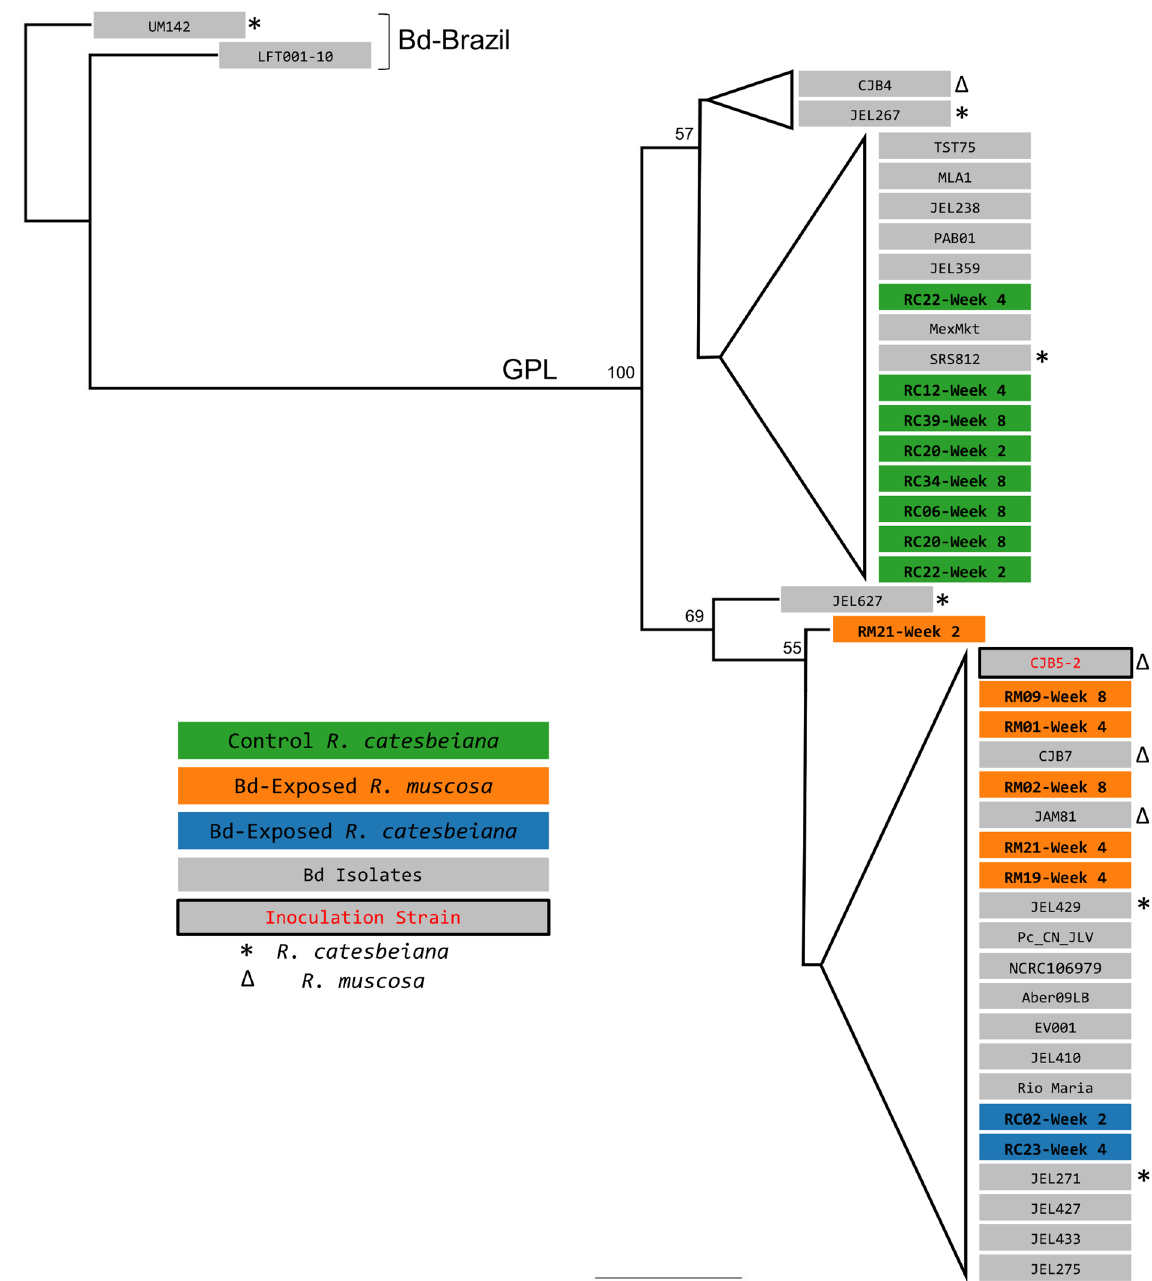
Fig 3. Phylogenetic comparison of Bd DNA collected via swabs during the experiment. Best-scoring maximum likelihood tree for 26 Bd isolates and 16 skin swab samples from 90 concatenated nuclear loci (12,080–12,103 bp). Bootstrap values above 50% (out of 1000 replicates) are shown and branches reproduced in less than 50% of bootstrap replicates are collapsed. Tree was rooted at Bd isolate UM142 based on previous phylogenetic characterization of the isolates used in this study [37]. Major Bd clades (Bd-Brazil and GPL) are indicated on the phylogeny. The Bd isolate used for inoculation in this study is indicated by a black box with red text. Bd cultures originally isolated from R . catesbeiana individuals are denoted with a (cid:3) and Bd cultures originally isolated from R . muscosa are denoted with a Δ